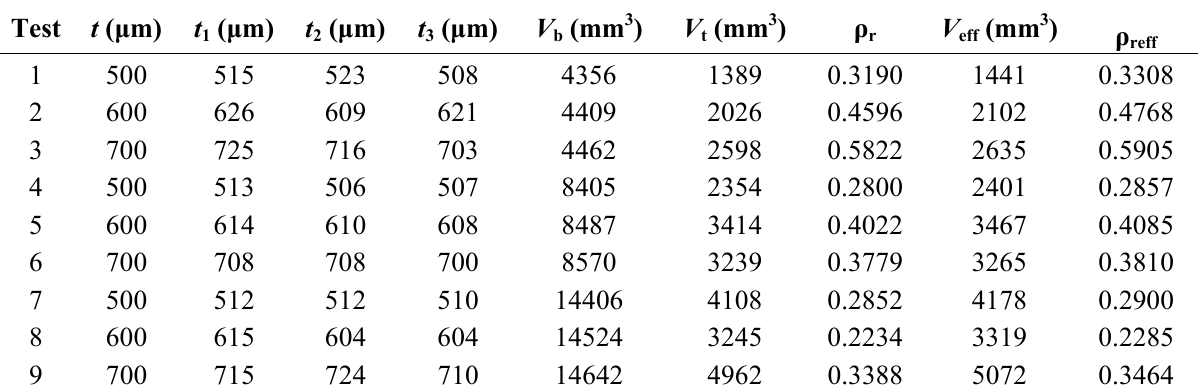
Table 2. Results of stereomicroscope analysis and evaluation of effective relative